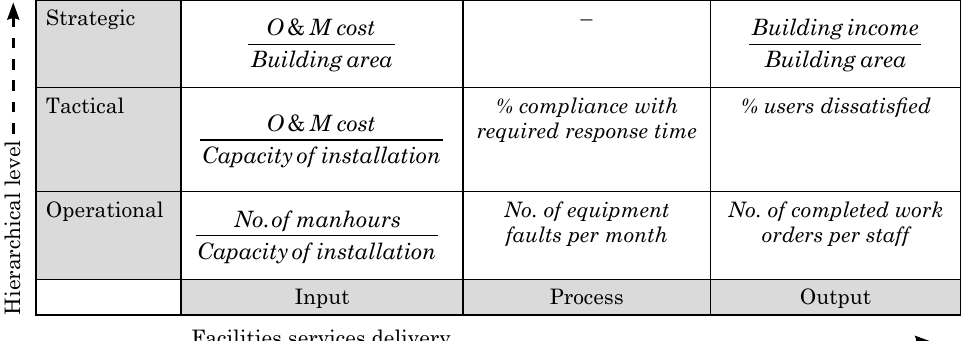
Fig. 3. An integrated process-hierarchy model for KPIs